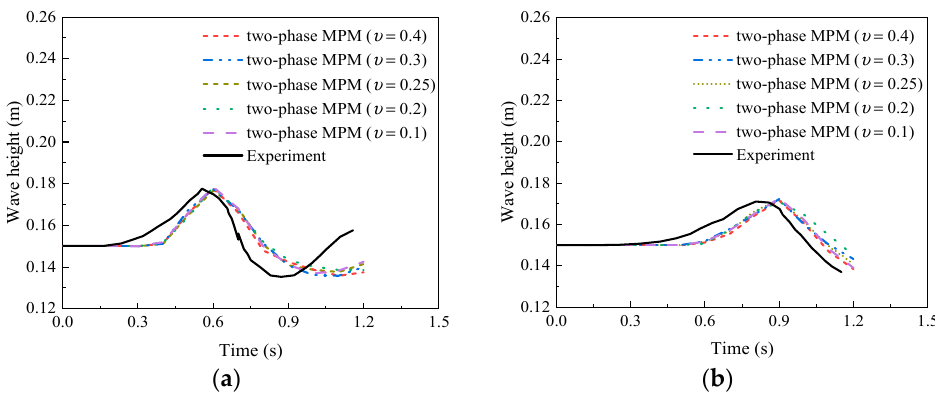
Figure 13. Influence of Poisson ratio of sliding sand: time history curve of the free water surface at two different locations: ( a ) X1 = − 0.3 m; ( b ) X2 = − 0.6 m.